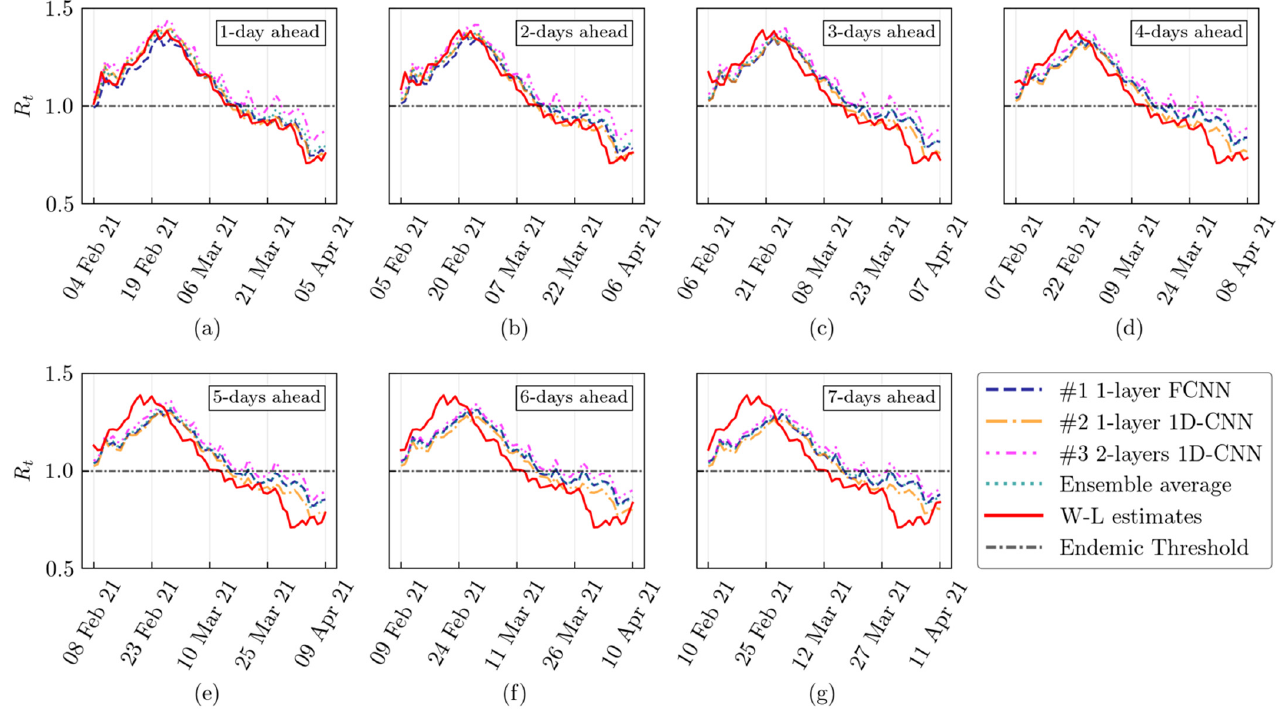
Figure 3. Lombardy Model evaluation. Predictions obtained by means of the regional three best models and their average ensemble model are compared with Wallinga–Lipsitch R t estimates in the period from 4 February 2021 to 11 April 2021. The endemic threshold ( R t = 1) is also reported. Table 3. Regional RMSE on the test set for the top three